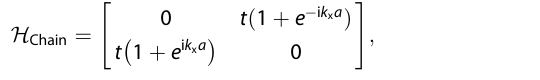
= 2, x = 0.40 Fig. 3 Dimension-crossover of the Dirac fermion. a , b Crystal structure of ( a ) x = 0.43 ( n = 3) and ( b ) x = 0.40 ( n = 2) sample. c , d Schematic of the ( c ) 1D and ( d ) 2D Dirac fermion along the S-X-S direction ( k y ). e The energy contour near Fermi energy ( E F ) of the k x − k y plane with theoretical BZ appended (black solid lines). f , g The spectrum ( f ) along Γ (cid:1) X (cid:1) Γ and the spectrum ( g ) at k y = − 0.30 Å − 1 (orange dashed lines) with linear fi tting result of the Dirac fermion appended for x = 0.43 sample. h – j Same as e – g , but for x = 0.40 sample. Data in Fig. 3e – j were collected at h ν = 56